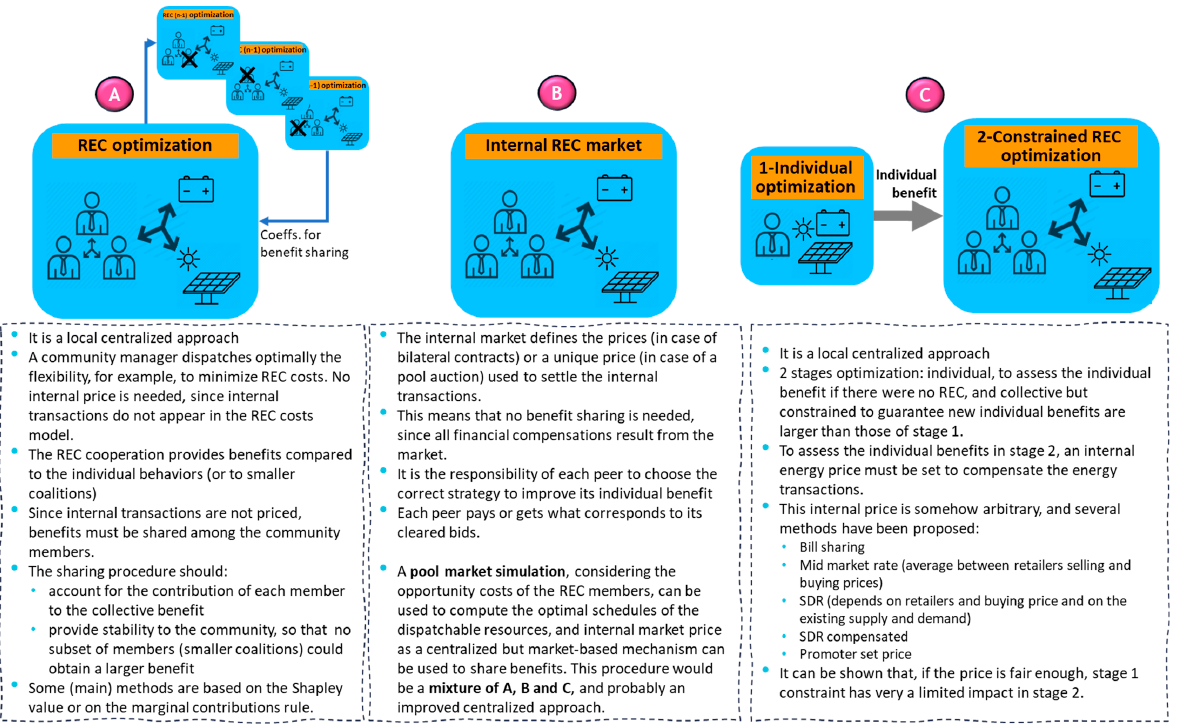
Figure 2. Sharing collective benefits in energy communities, when managed with a centralized optimization approach ( A ), with an internal local market ( B ), or with a constraint centralized optimization that guarantees all individual benefit from belonging to the REC ( C ).